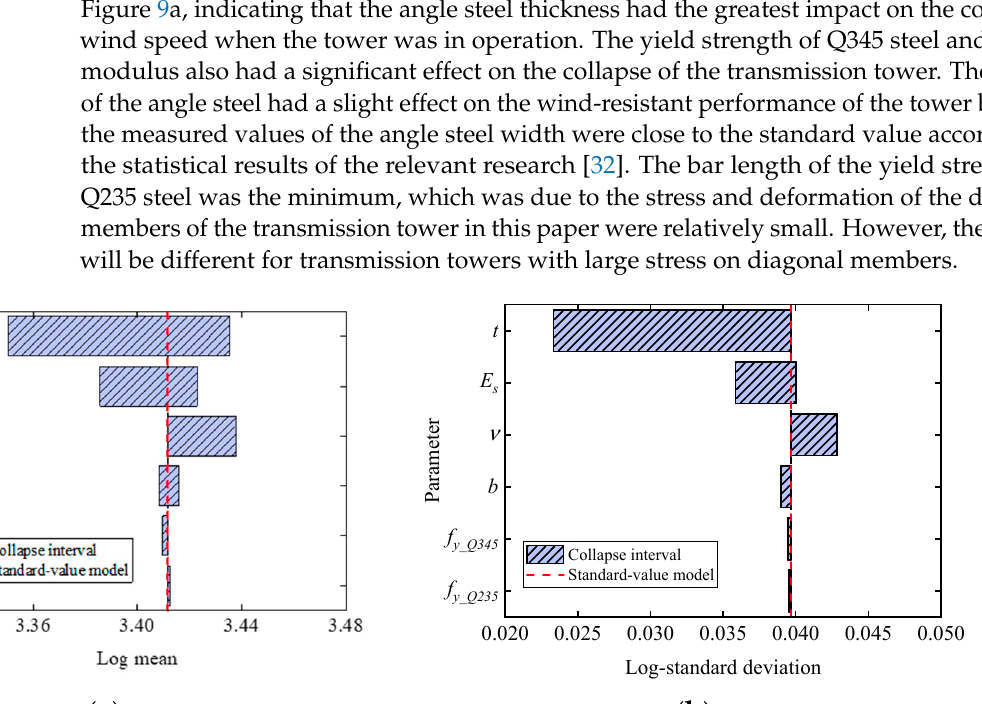
Figure 9. Tornado chart of collapse wind speeds. ( a ) Log mean of basic collapse wind speeds. ( b ) Figure 9. Tornadochartofcollapsewindspeeds. ( a )Logmeanofbasiccollapsewindspeeds. ( b ) Log-standard deviation of basic collapse wind Log-standard deviation of basic collapse wind speeds.